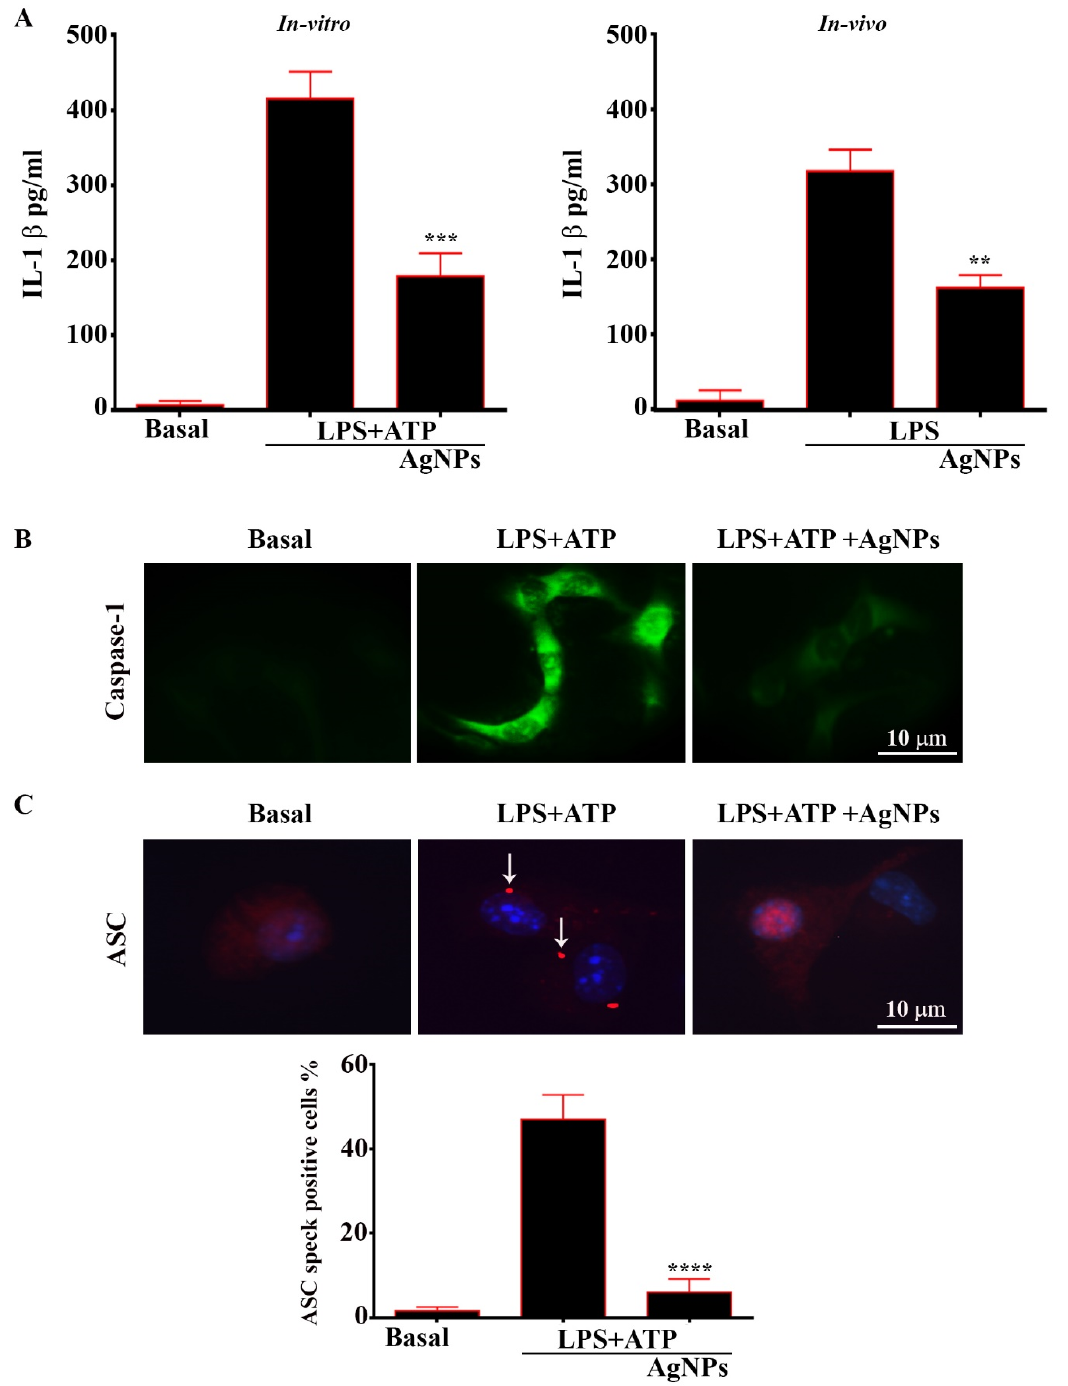
Figure 10. AgNPs inhibit inflammasome activation. ( A ), AgNPs inhibit IL-1-beta secretion in-vitro and serum of treated mice ( in-vivo ) . Asterisks indicate statistically significant difference from LPS+ATP-treated cells in the presence and absence of AgNPs at a concentration of 5 μ gmL − 1 . Results are presented as mean ± SD. ** p < 0. 01, *** p < 0.001, **** p < 0.0001. ( B ), Immunofluorescence images of Caspase-1 in cells. Cells were left untreated or treated with LPS+ATP in the presence and absence of AgNPs at a concentration of 5 μ gmL − 1 . Cells were fixed, permeabilized, and stained with DAPI to visualize nuclei (blue); Caspase-1 staining is shown in green. Scale bar, 10 μ m. ( C ), Immunofluorescence images of ASC. Cells were treated with LPS+ATP in the presence and absence of AgNPs at a concentration of 5 μ gmL − 1 . Cells were fixed, permeabilized, and stained with DAPI to visualize nuclei (blue); ASC staining is shown in red. The white arrow represents ASC specks Scale bar, 10 μ m. Graph represented Percentage of cells containing ASC speck.